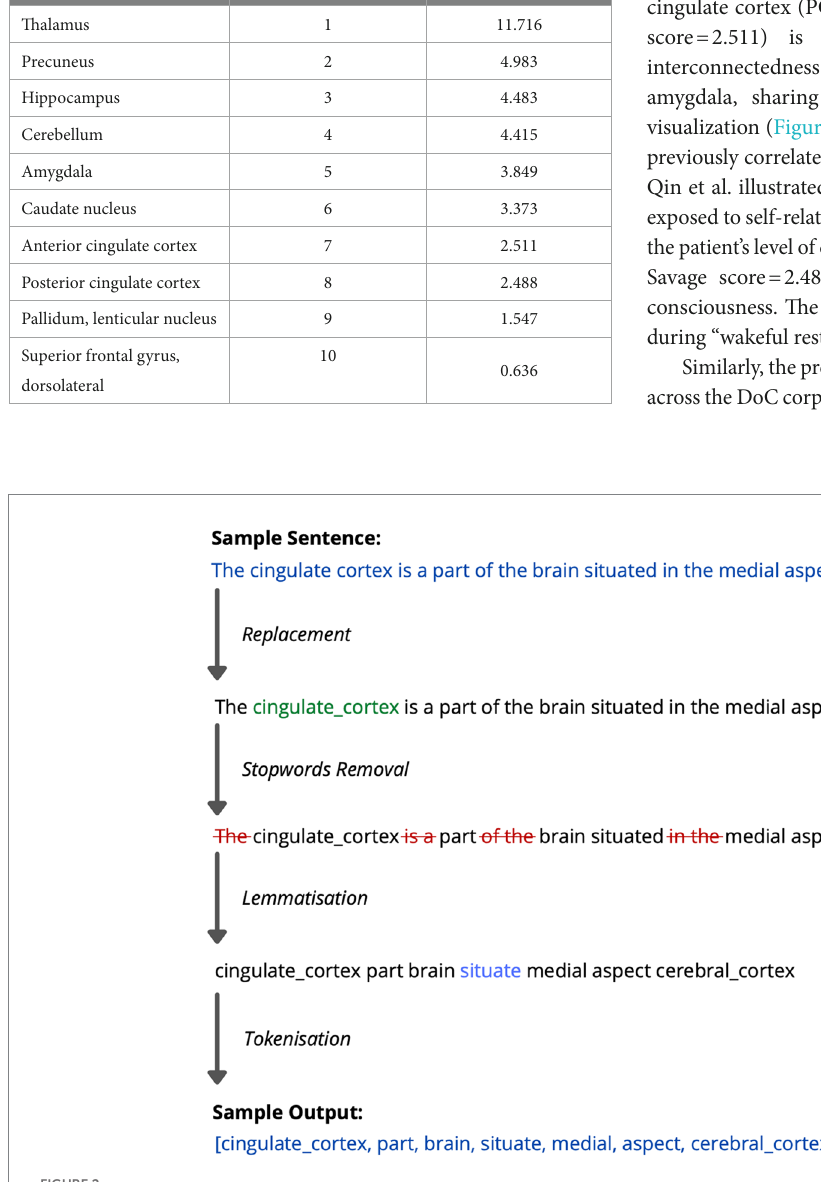
FIGURE 2 Flowchart illustrating some of the pre-processing steps undertaken during the text mining process. An example sentence is used.